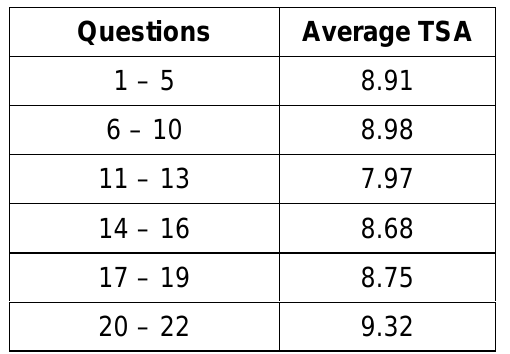
Table 2. Average TSA per question